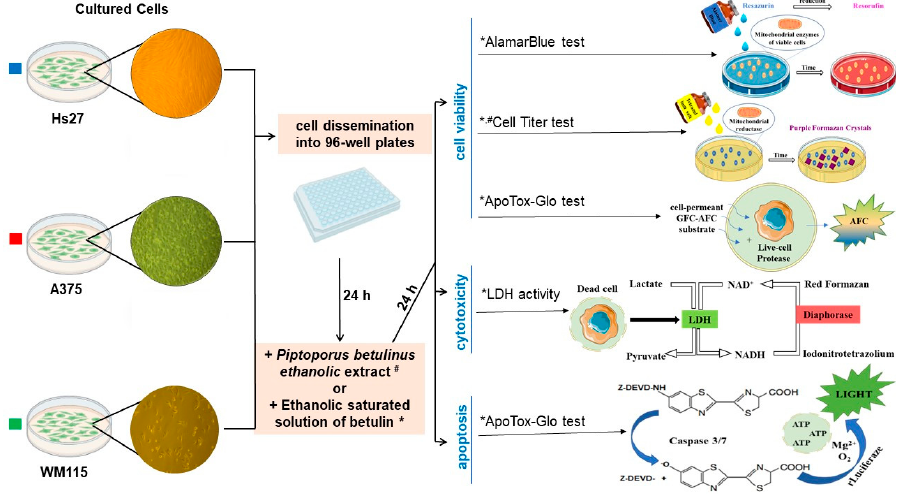
Figure 7. Scheme of in vitro cell-based assays used to determine Hs27, A375, and WM115 cell viability, cytotoxicity, and apoptosis in the presence of Piptoporus betulinus extact (tests marked in the figure with a hash mark (#)), and cell viability in the presence of betulin solution (tests marked in the figure with an asterisk (*)), and their